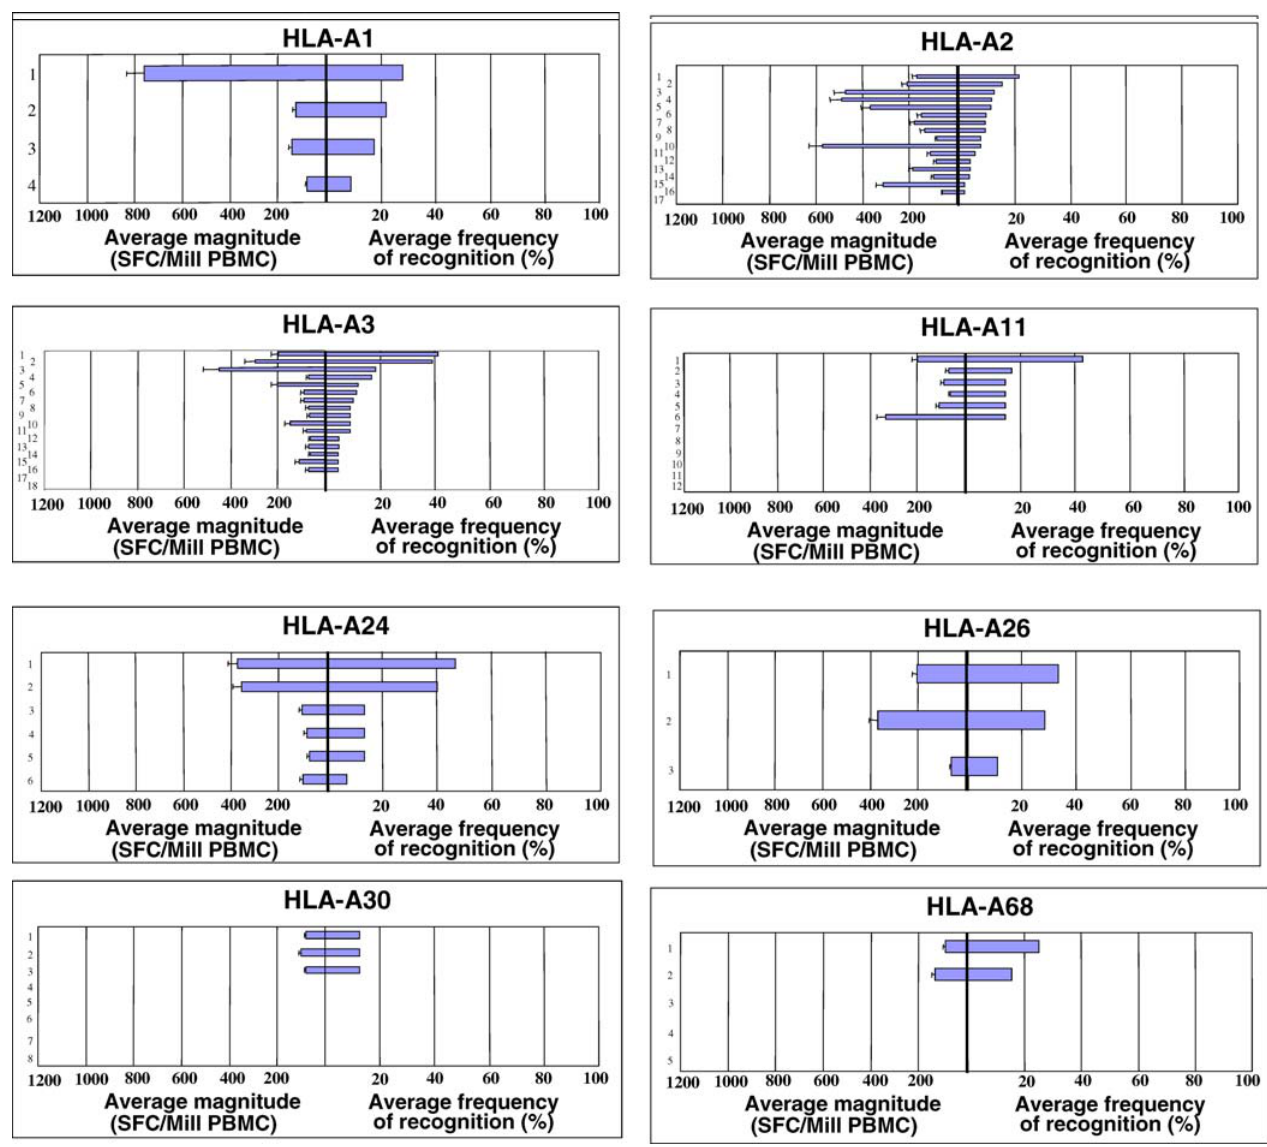
Figure 1. Immunodominance Patterns for HIV-1-Specific CD8 þ T Cell Responses Restricted by Individual HLA Class I Alleles Peptides corresponding to described optimal HIV-1-specific CD8 þ T cell epitopes were tested in all study participants expressing the respective HLA class I allele. The average magnitude of CD8 þ T cell responses specific for each tested peptide, given as SFCs per million input PBMCs (SFC/Mill PBMC), are shown as bars in the left part of each graph. The percentage of participants expressing the respective allele that had a detectable peptide-specific CD8 þ T cell response are shown as bars on the right part of each graph. Epitopes are aligned for each HLA class I allele according to their frequency of recognition from top to bottom. The peptide number corresponds to the peptide sequence listed for each HLA allele and number in Table 2. Data are shown only for HLA class I alleles that were expressed in at least three individuals, and for which at least three HIV-1-specific optimal CD8 þ T cell epitopes had been defined. DOI: